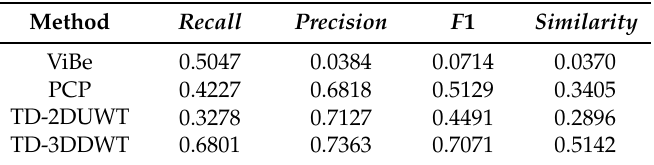
Table 7. Comparison of average metrics for the intermittent pan sequence.